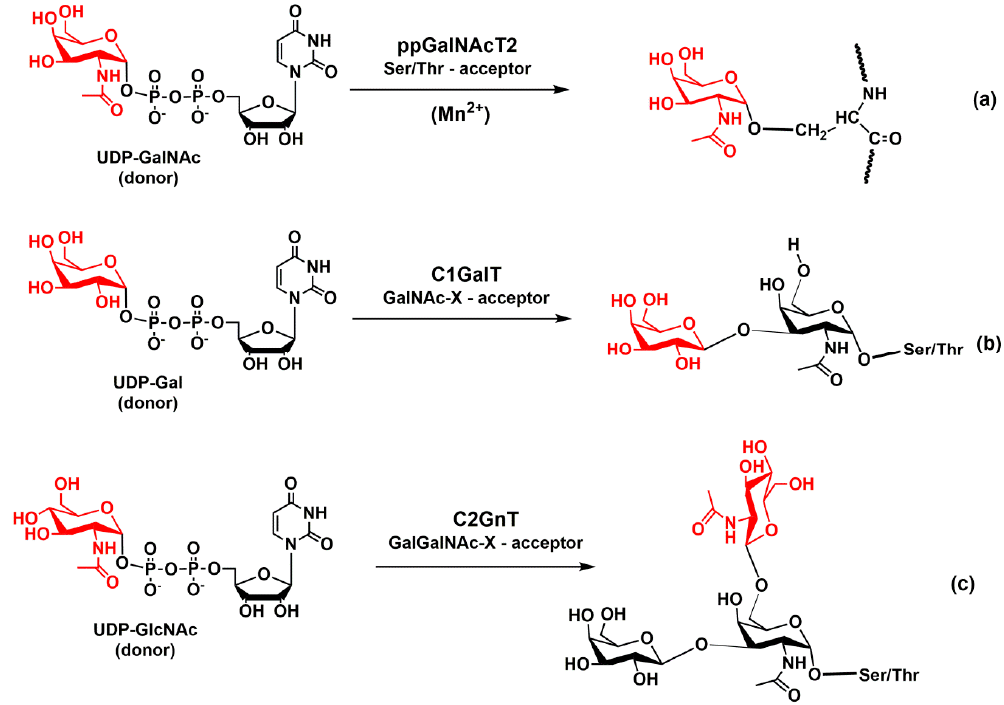
Figure 7. Schematic diagram of enzymatic reaction catalyzed by ( a ) ppGalNAcT2, ( b ) Core-1 GalT, and ( c ) core-2 GnT.